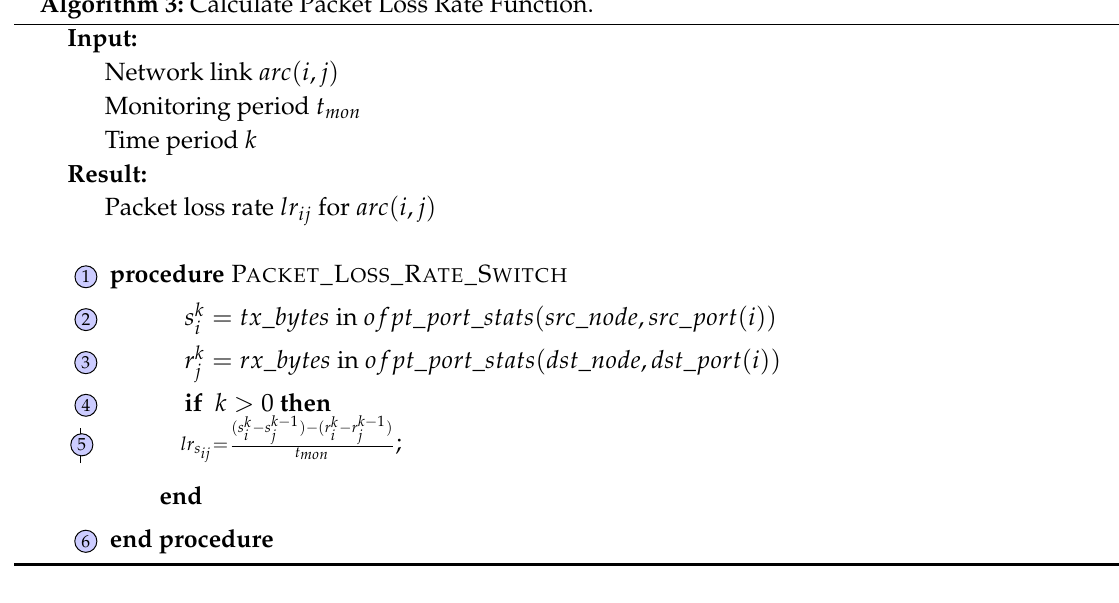
Algorithm 3: Calculate Packet Loss Rate Function.